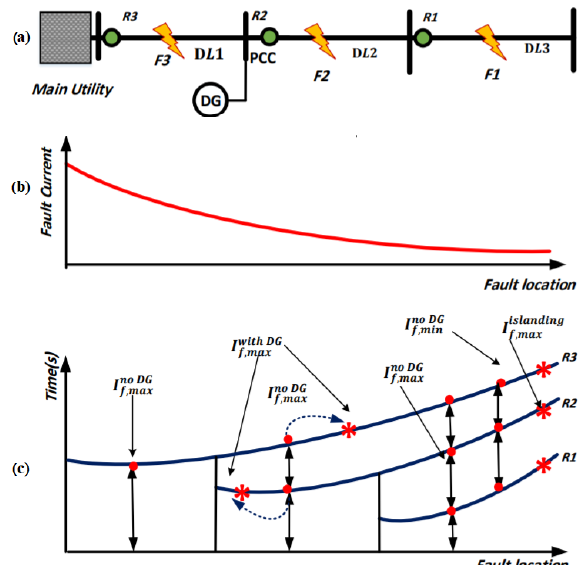
Figure 3. ( a ) The single-line diagram of the distribution grid with DG under three fault modes, ( b ) the relationship between fault current and fault location, and ( c ) the miscoordination between the primary and backup relays and fault characteristics with the absence and presence of DG.